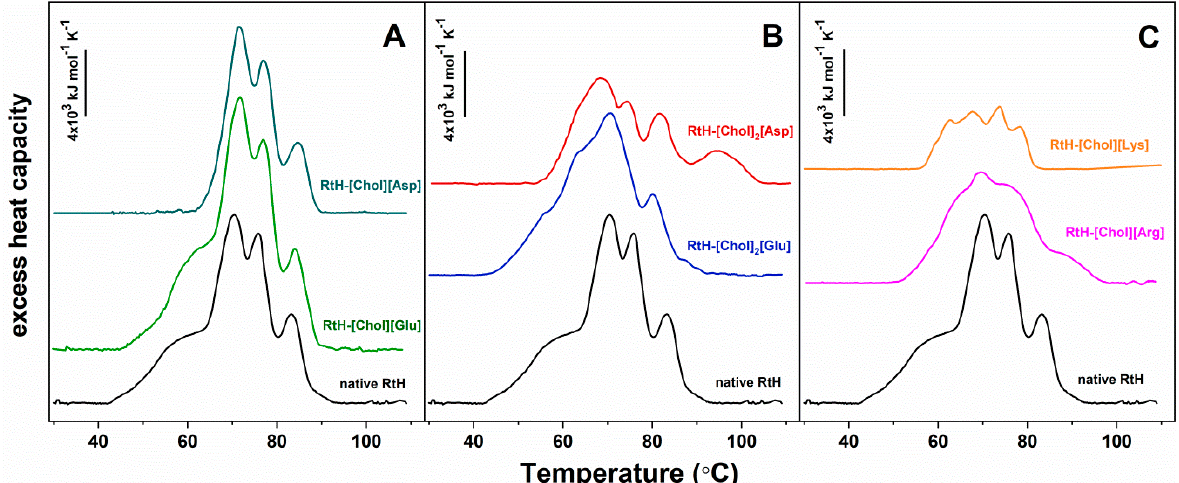
Figure 5. Thermal denaturation profiles of native RtH (3 mg/mL) in sodium phosphate buffer (pH 7.4, 50 mM) in the presence of 0.02 M [Chol] n [AA]. Heating rate –1 °C/min. For a comparison the DSC curves are grouped as follows: complexes of RtH with monocholinium salts containing anion of a negatively charged amino acid ( A ), a positively charged amino acid ( B ), and dicholinium salts ( C ).